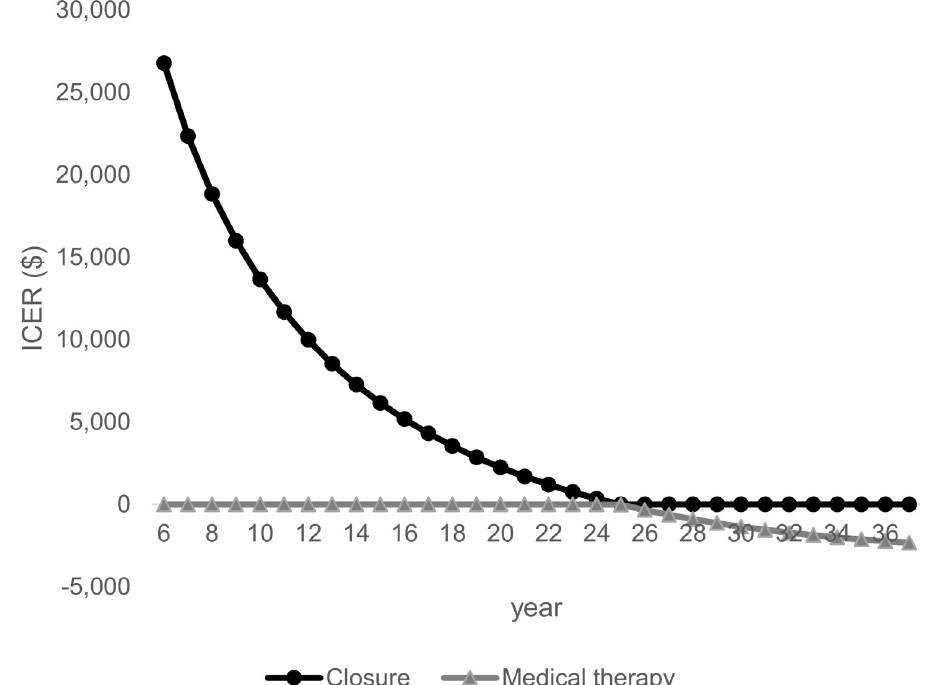
Fig 5. One-way sensitivity analysis: Time horizon closure vs. medical therapy. Time horizon closure vs. medical therapy, which is the second largest impact of parameter variation, is shown with ICER. Abbreviations. ICER, incremental cost-effectiveness ratio.